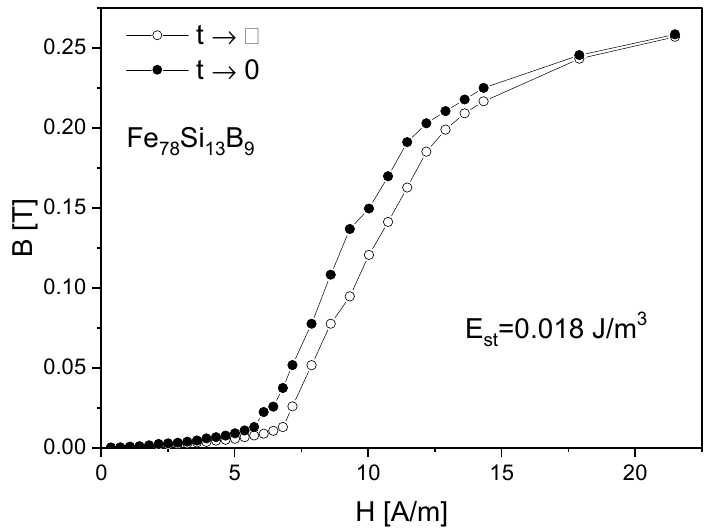
Figure 7. The B ( H , t ) curves obtained by static measurements, extrapolating to times t → 0 and t → ∞ after demagnetization.